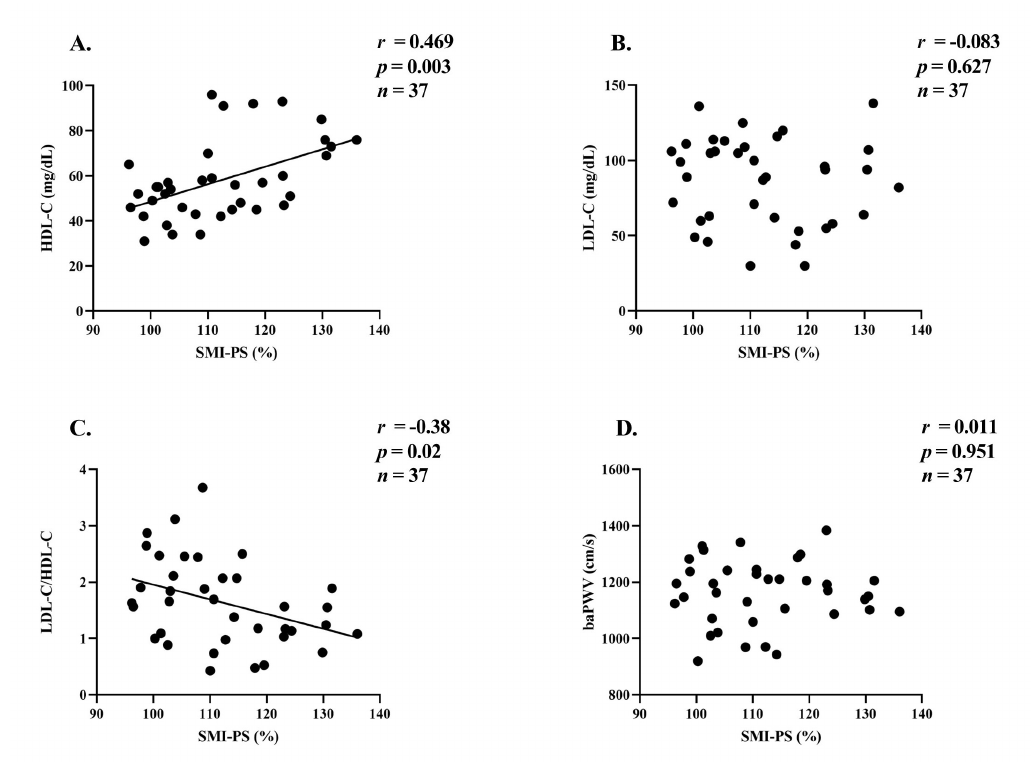
Fig. 3. Relationship between SMI-PS and HDL-C (A), LDL-C (B), LDL-C/HDL-C (C), and baPWV (D). SMI-PS, skeletal muscle mass index-percentile score; HDL-C, high density lipoprotein cholesterol; LDL-C, low density lipoprotein cholesterol; LDL-C/HDL-C, LDL-C to HDL-C ratio; baPWV, brachial-ankle pulse wave